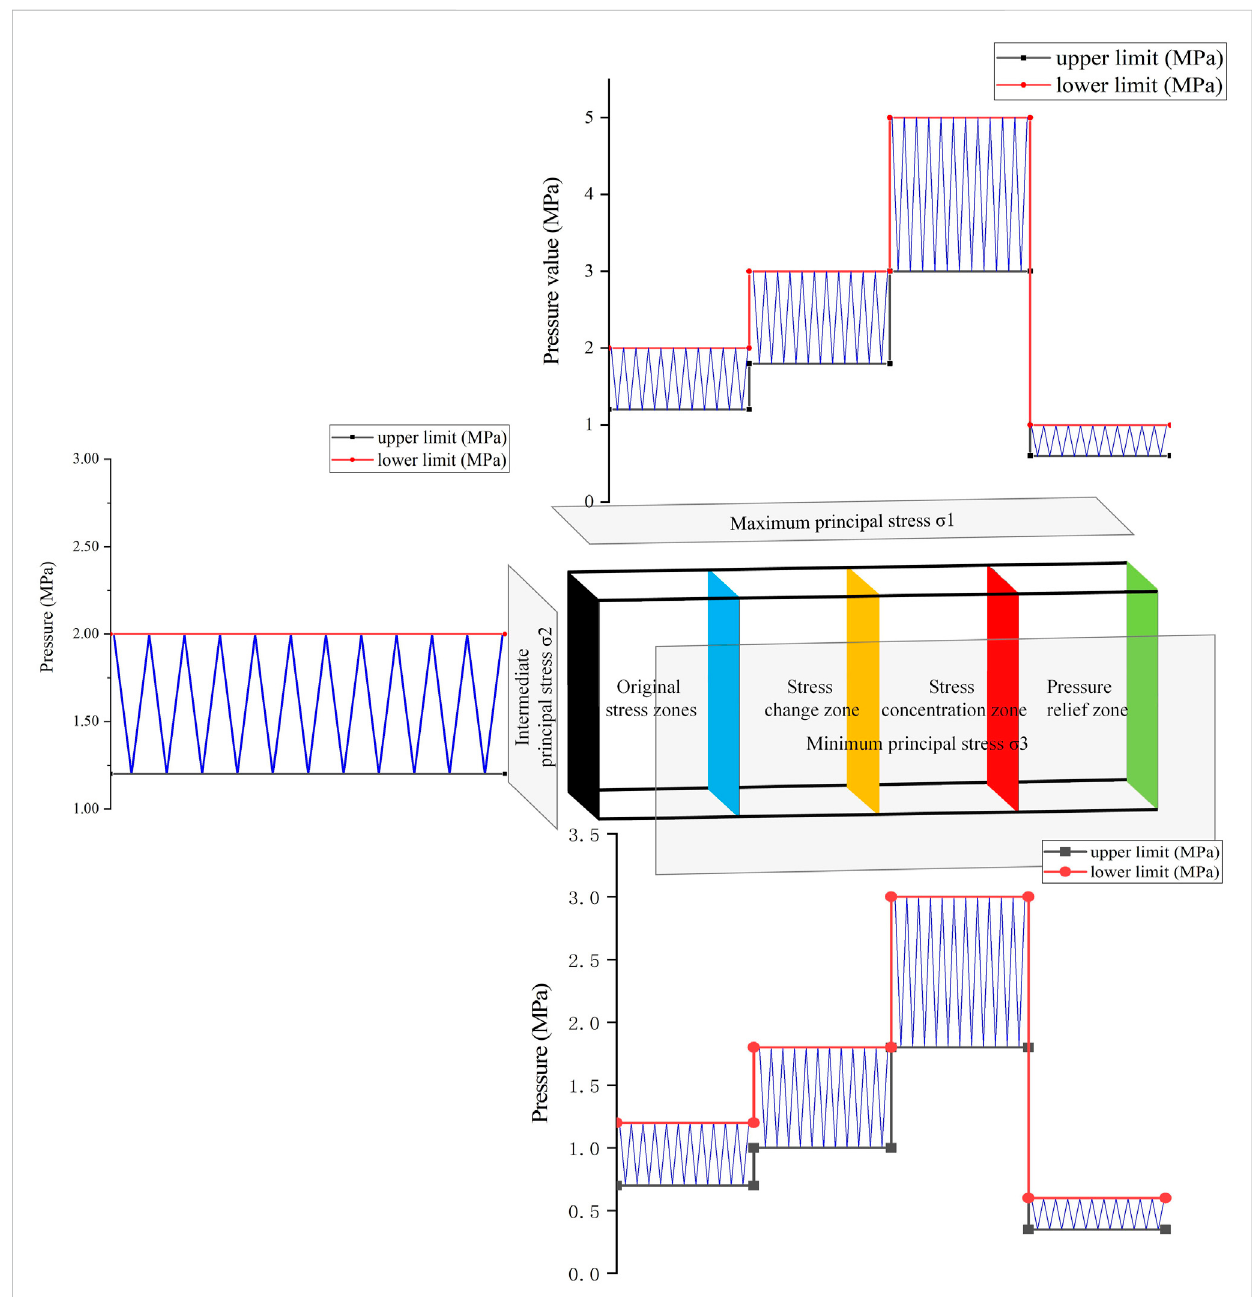
FIGURE 4 Simulated box and stress distribution diagram.